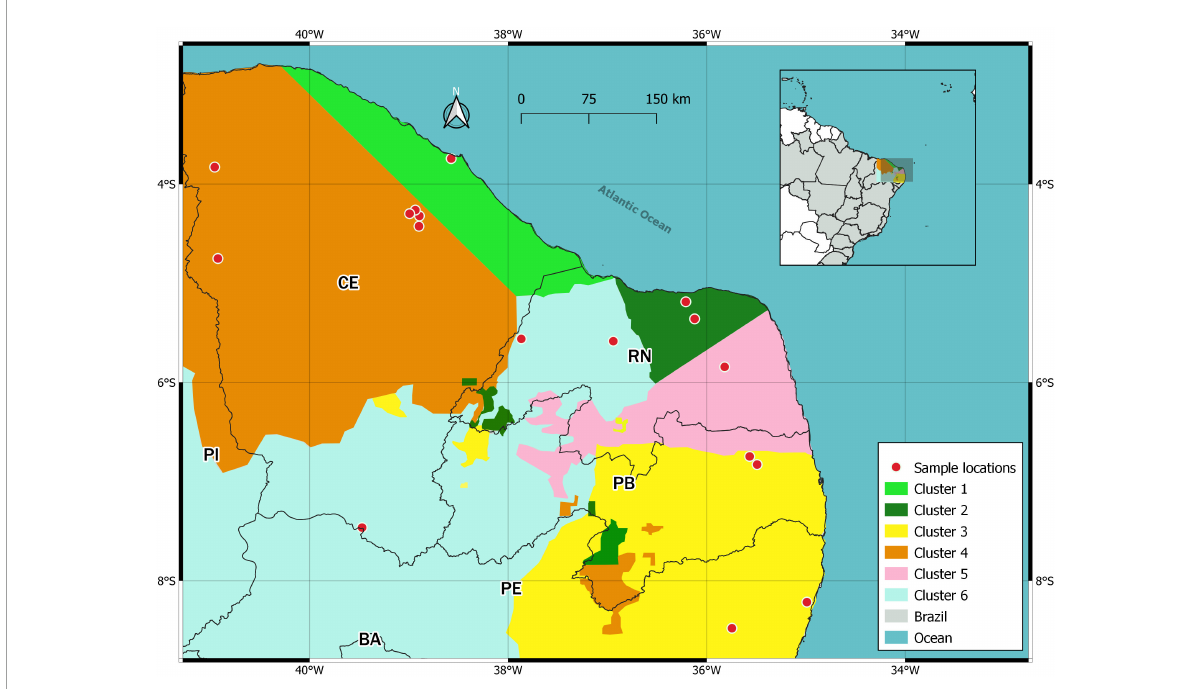
FIGURE7 Map of the locations where P . flavocincta samples were collected in Northeast Brazil for genetic analysis. The colors indicate the six different populations identified by Geneland software (K = 6).